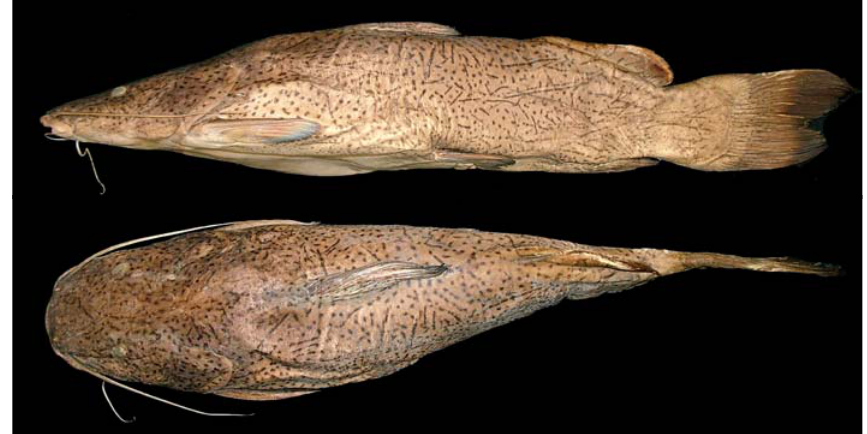
Fig. 7 . Lateral and dorsal views of S. scriptum . MZUSP 88015, 690 mm SL, Jaguara, rio Grande, cachoeira Mata-Doutor, downstream of Jaguara hydroelectric power dam, São Paulo,